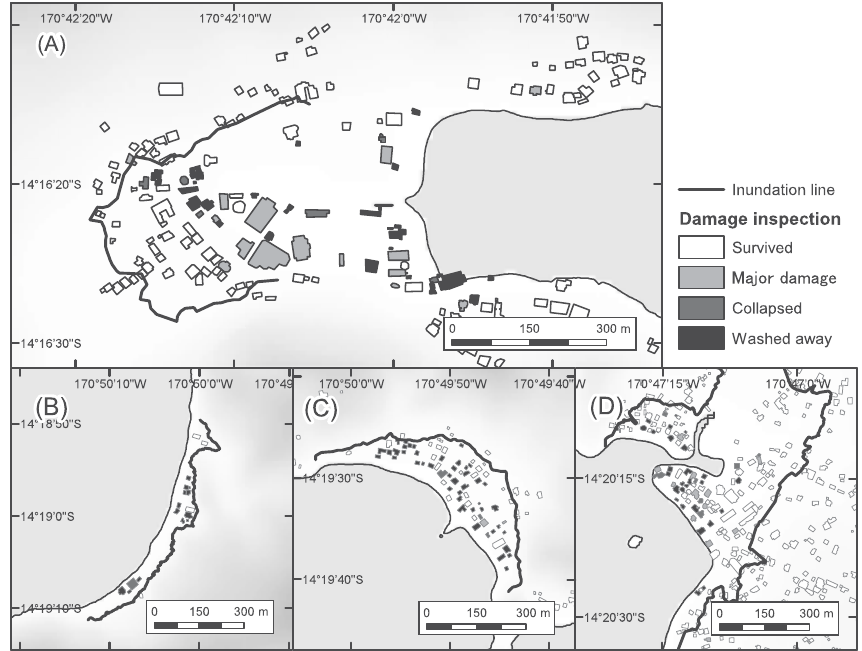
Figure 7. Interpreted building damage at (a) Pago Pago, (b) Poloa, (c) Amanave and (d)